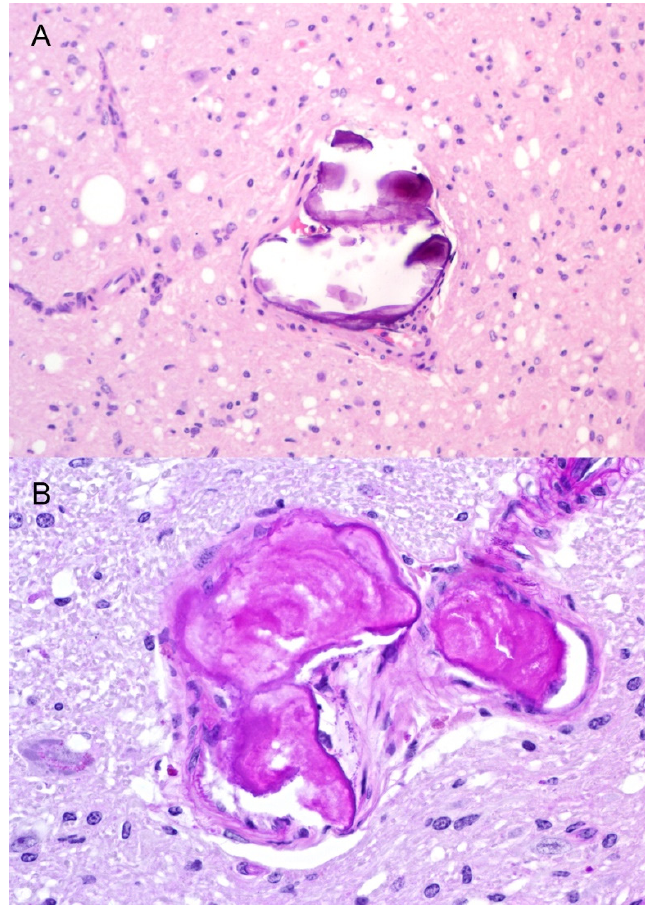
Figure 6. Corpora amylacea at the level of the obex. ( A ) Hematoxylin and eosin stain of calcified material in the subpial layer of a small vessel. ( B ) Periodic acid–Schiff stain is positive (fuchsia/magenta) for glycoproteins in the concentrically laminated material. Original magnification ( A ) 400×; ( B ) 600×.